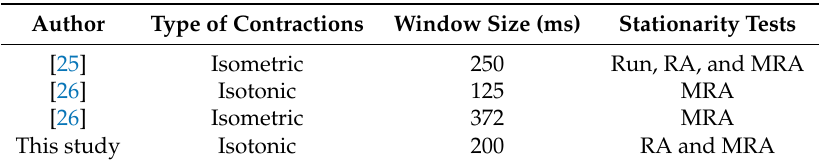
Table 1. Comparison of suitable window size with different types of contractions. RA: reverse arrangement; MRA: modified reverse